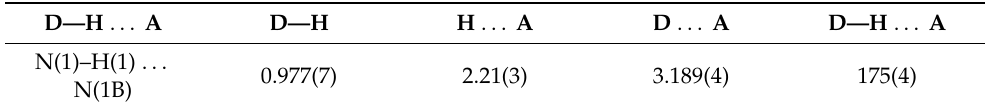
Figure 2. Structures of 1 showing IUPAC numbering and observed conformation. 62 Table 1. Hydrogen bonding parameters for 1 (Å , °).